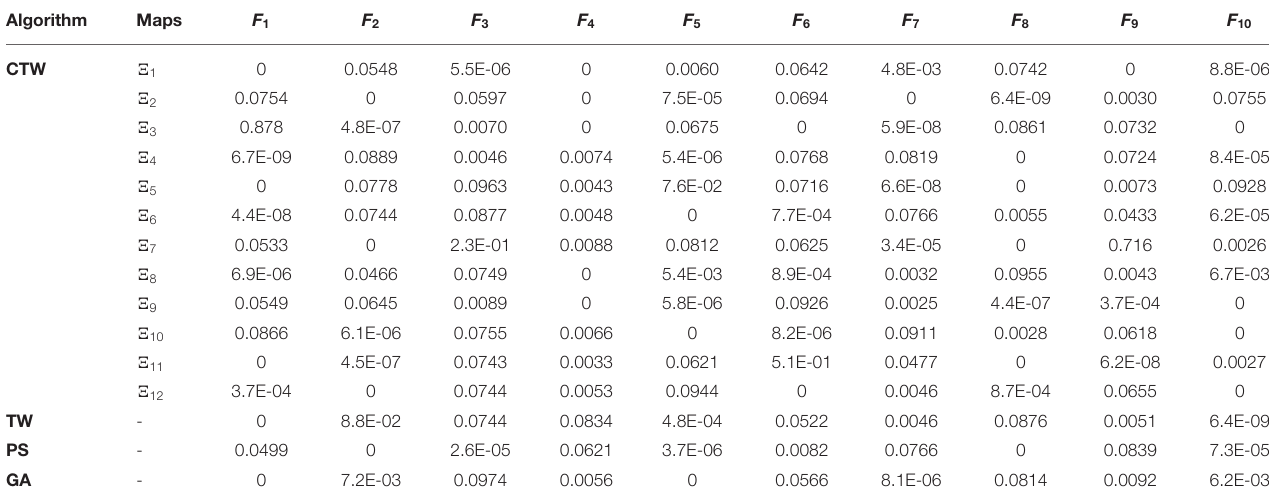
TABLE 1 | The results of Chaotic Tug of War (CTW) with different chaotic maps, Tug of War (TW), Genetic Algorithm (GA), and Particle Swarm (PS) (24). Algorithm